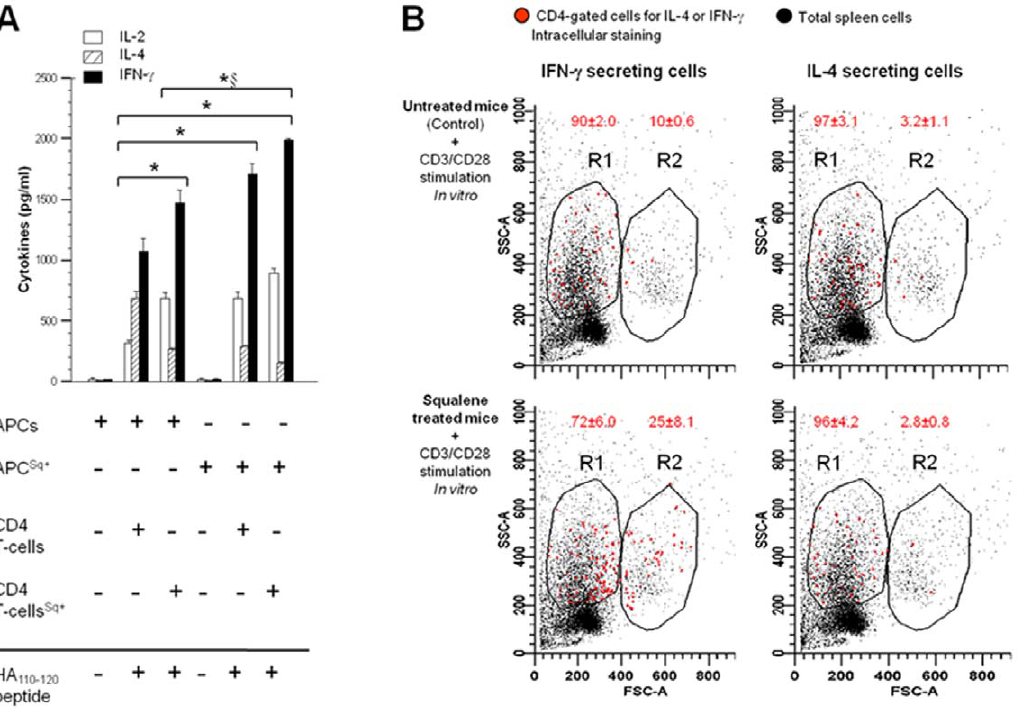
Figure 6. Squalene induced accumulation of membrane cholesterol in resting CD4 T cells favors Th1 polarization under antigen- specific or non antigen specific stimulation. (A) Isolated adherent splenocytes (APCs, 5 6 10 5 ) from individual F1 mice treated or not with 180 m g of squalene, were pulsed ( + ) or not pulsed (-) with HA 110–120 synthetic peptide (40 m g/mL/10 6 cells) in vitro 7 days after squalene injection, and co- cultured with negatively-sorted CD4 splenic T-cells (10 6 cells) from the same groups of mice, treated or not with squalene (Sq) (n=4/group). Various cell co-culture combinations are shown on the X-axis, where ( + ) indicates presence and (–) indicates absence from the culture. Cell-culture supernatants were collected 24–48 h later, and secretion of IL-2, IL-4, and IFN- c (Y-axis) was measured in pg/ml by Luminex. Bars represent average 6 SD. Differences among groups were highly significant ( p , 0.001) for cytokines with the following exceptions denoted as 1 : For IL-4, co-culutre in lane 6 differed significantly from lane 5 ( p =0.047) but not from lane 3 ( p =0.097). No significant difference was observed between co-culture in lane 3 and 5 for any of the three cytokines. ( B ) Intracellular cytokine staining for IFN- c ( left panels ) and IL-4 ( right panels ) in splenic cells and CD4-gated splenic cells from individual untreated ( top panels ) and squalene treated F1 mice ( bottom panels ) (n=3/group) were stimulated for 48 h with anti-CD3/CD28 Abs (2.5 m g each/10 6 cells). Shown are the overlapped FACS histograms of gated CD4 + T cells synthesizing IL-4 or IFN- c (red cell events), and total splenic cells (dark cell events) from squalene treated or untreated F1 mice, 7 days after squalene treatment. R1 gate indicates the low-proliferating cell population whereas the R2 gate indicates the high proliferating cell population in each experiment. Dead cells are shown in the un-gated cell population below the R1 gate. Shown is one of two representative